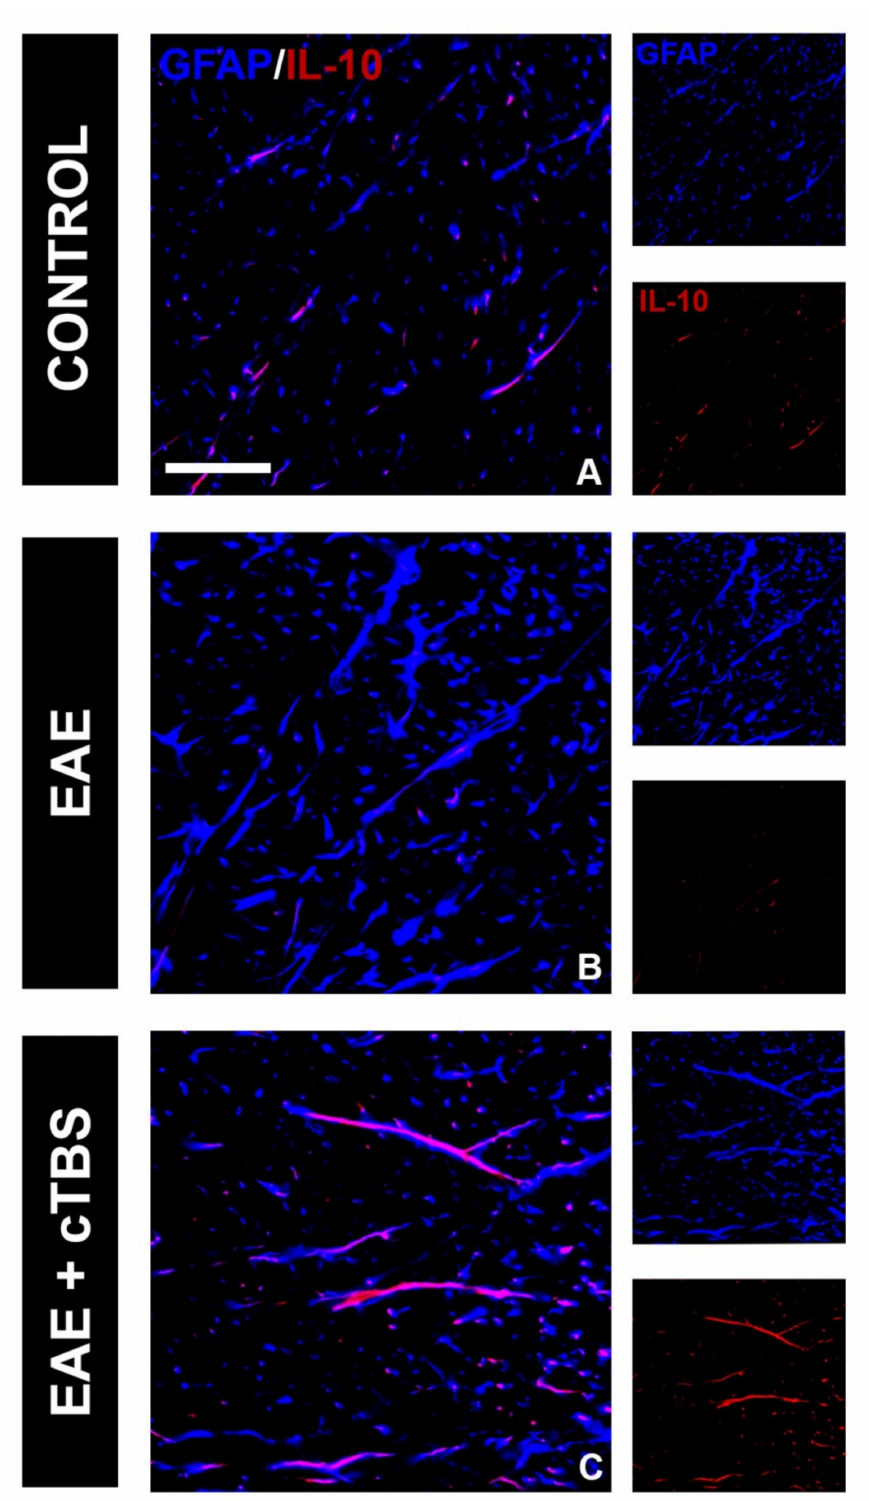
Figure 5. Effects of CTBS treatment on IL-10 expression in EAE rats. Double immunofluorescence labeling directed to astrocyte marker GFAP (blue) and anti-inflammatory cytokine IL-10 (red). Control sections revealed modest colocalization of IL-10 and GFAP ( A ), which was barely detectable in EAE animas ( B ). CTBS treatment led to marked increase in immunostaining of IL-10, which was confined to quiescent GFAP + cells ( C ). Scale bar corresponds to 50 µ